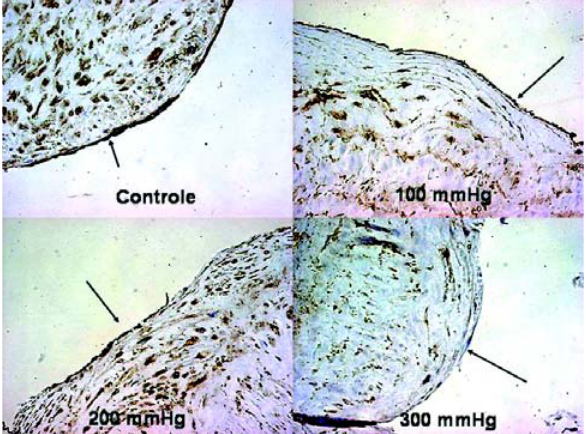
Fig. 4 - Imunohistoquímica do CD34. As setas indicam a diminuição da expressão com a pressurização (400